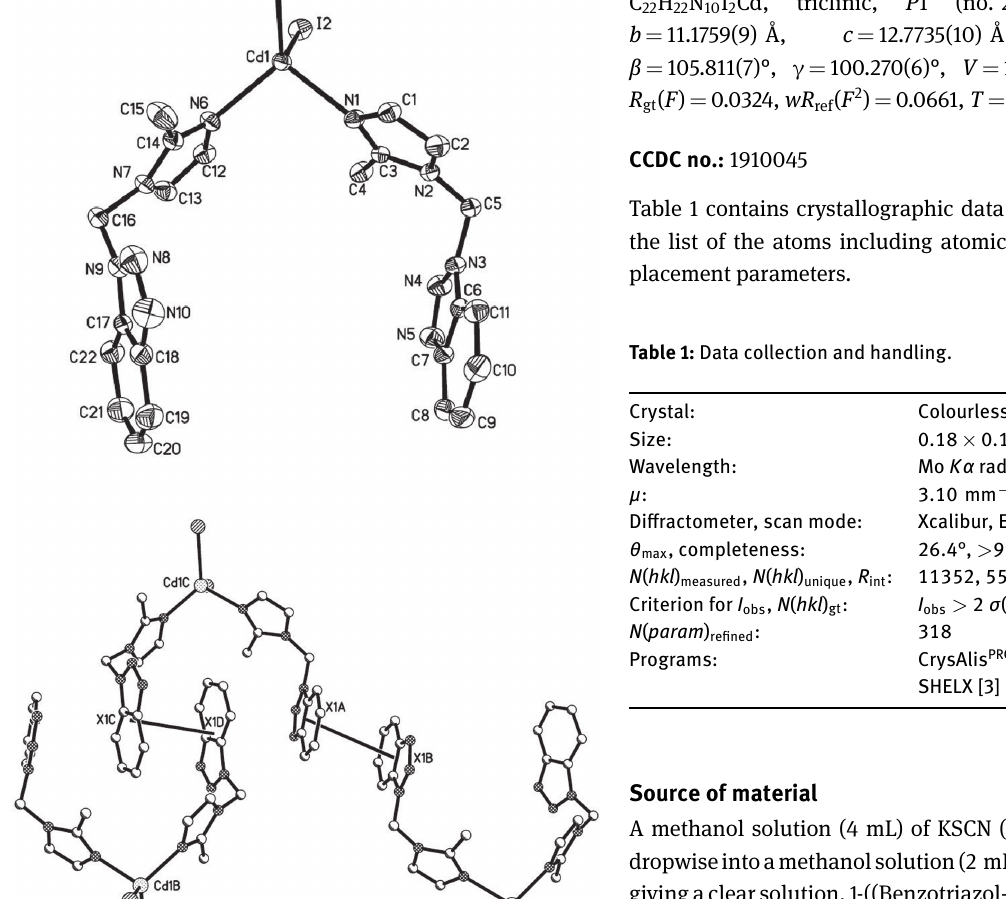
Table 1 contains crystallographic data and Table 2 contains the list of the atoms including atomic coordinates and dis- placement parameters.